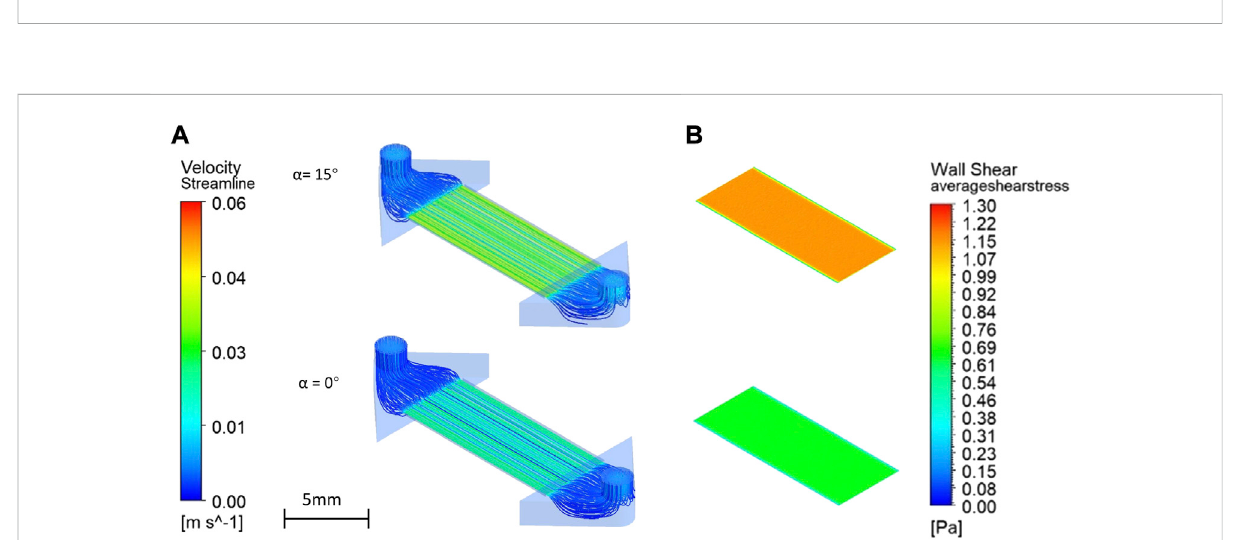
FIGURE 8 The fi nishedOOCwithalargeinletontheedgeandzoomedin(electron)microscopicimagesshowingthenanoporousSi x N y membranewitha pore size of 650 nm.